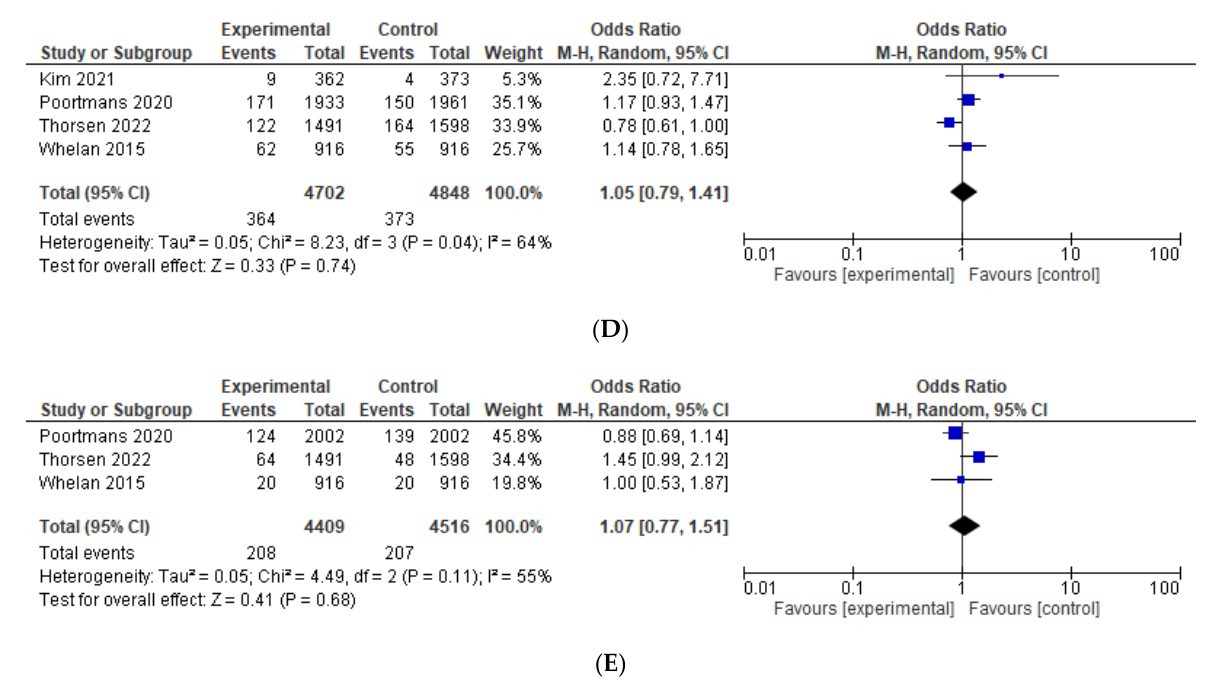
Figure 5. Forest plots for the toxicity, odds ratio for: ( A ) second malignancy; ( B ) cardiovascular morbidity; ( C ) cardiovascular mortality; ( D ) non-breast cancer related mortality; ( E ) contralateral breast cancer. The weight of each trial in the meta-analysis is represented by the size of the squares. The estimated pooled effect is represented by a diamond shape. p values are two-sided. References: Hen-